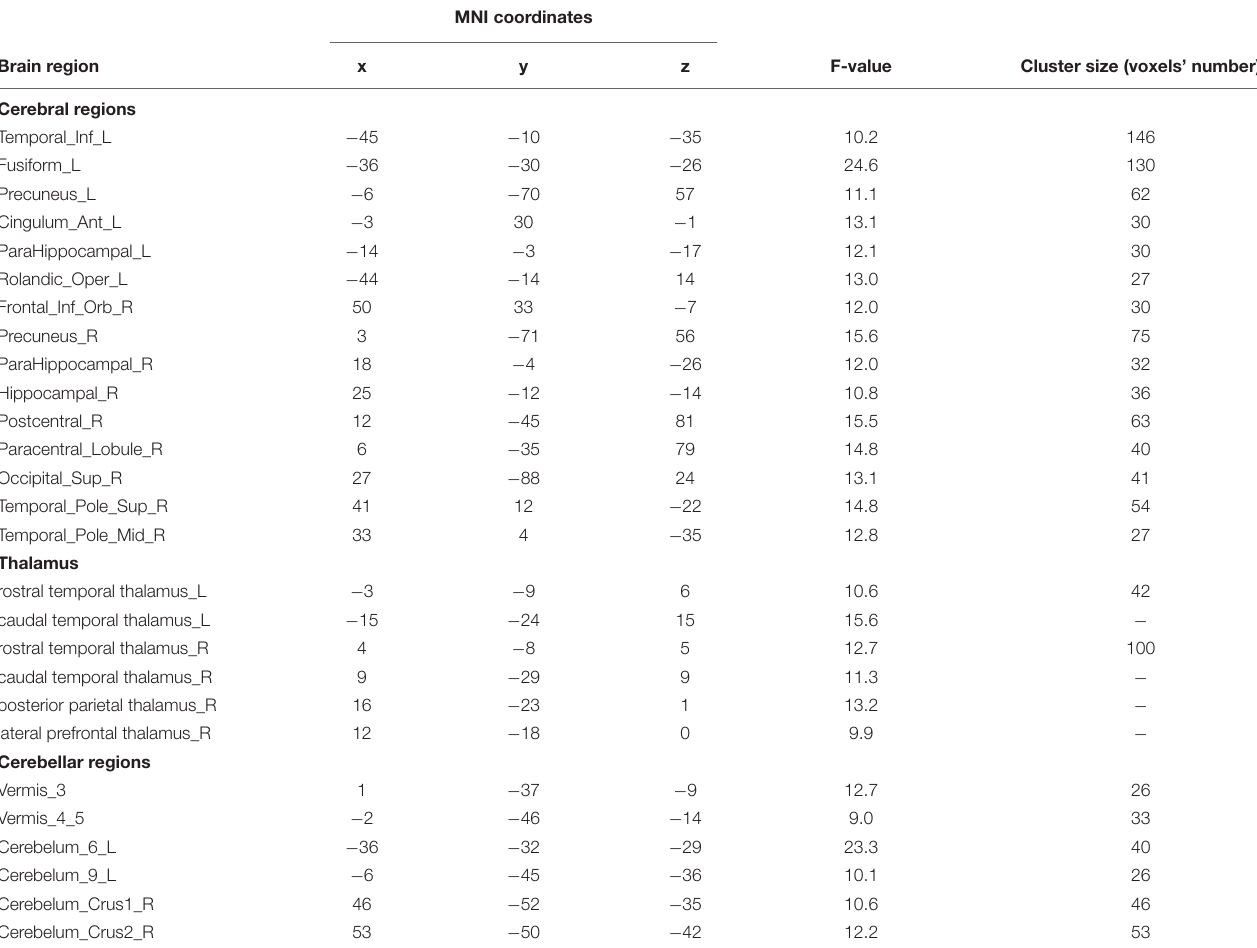
TABLE 3 | Significant interaction effects in voxel-wise functional connectivity (FC) temporal variability analysis. MNI